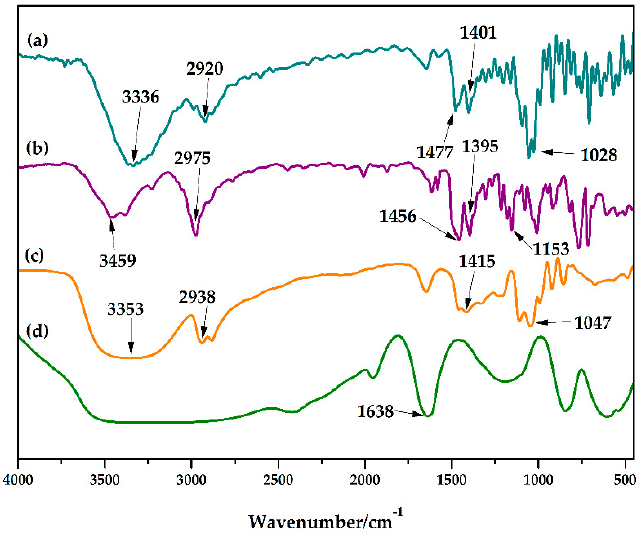
Figure 1. FT-IR spectra for ( a ) TEBAC/GL/ACH (1:2:0.05)-based DES, ( b ) TEBAC, ( c ) GL, and ( d ) ACH.